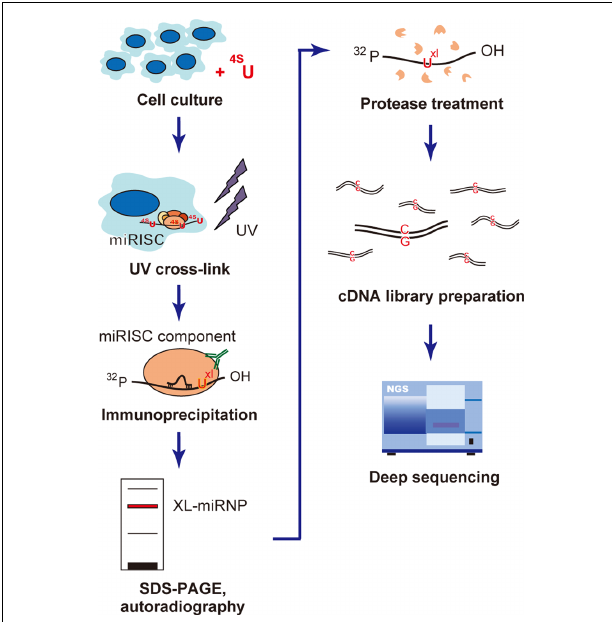
FIGURE 3 | Flow chart of the photoactivatable-ribonucleoside- enhanced cross-linking and immunoprecipitation (PAR-CLIP) methodology. PAR-CLIP analysis of miRISC component-binding RNAs.The cells are first cultured with photoreactive 4-thiouridine ( 4S U), which causes uridine to be incorporated during culture, and UV cross-linked to miRNP (U XL ).The cross-linked miRNP–RNA complexes are immunoprecipitated using an antibody directed against miRNP, and then size fractionized by SDS-PAGE.The miRNP–RNA complexes are extracted from the gel and digested with protease.The recovered RNA molecules are converted into cDNA, where the incorporated 4-thiouridine causesT → C transitions.This transition plays a key role in the accurate mapping of the miRNP-binding sites.The cDNA library is analyzed with the deep sequencing method to determine the RNA sequences capable of interacting with